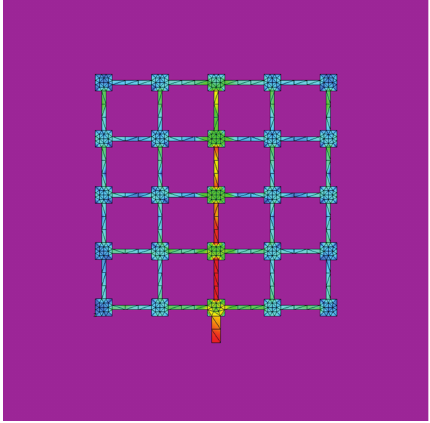
Figure 2: FEKO-meshed design of the array antenna with current distribution.